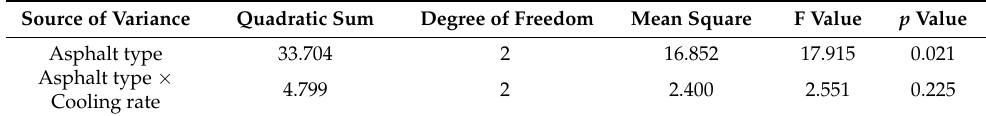
Table 8. Covariance analysis of the influence of the asphalt type